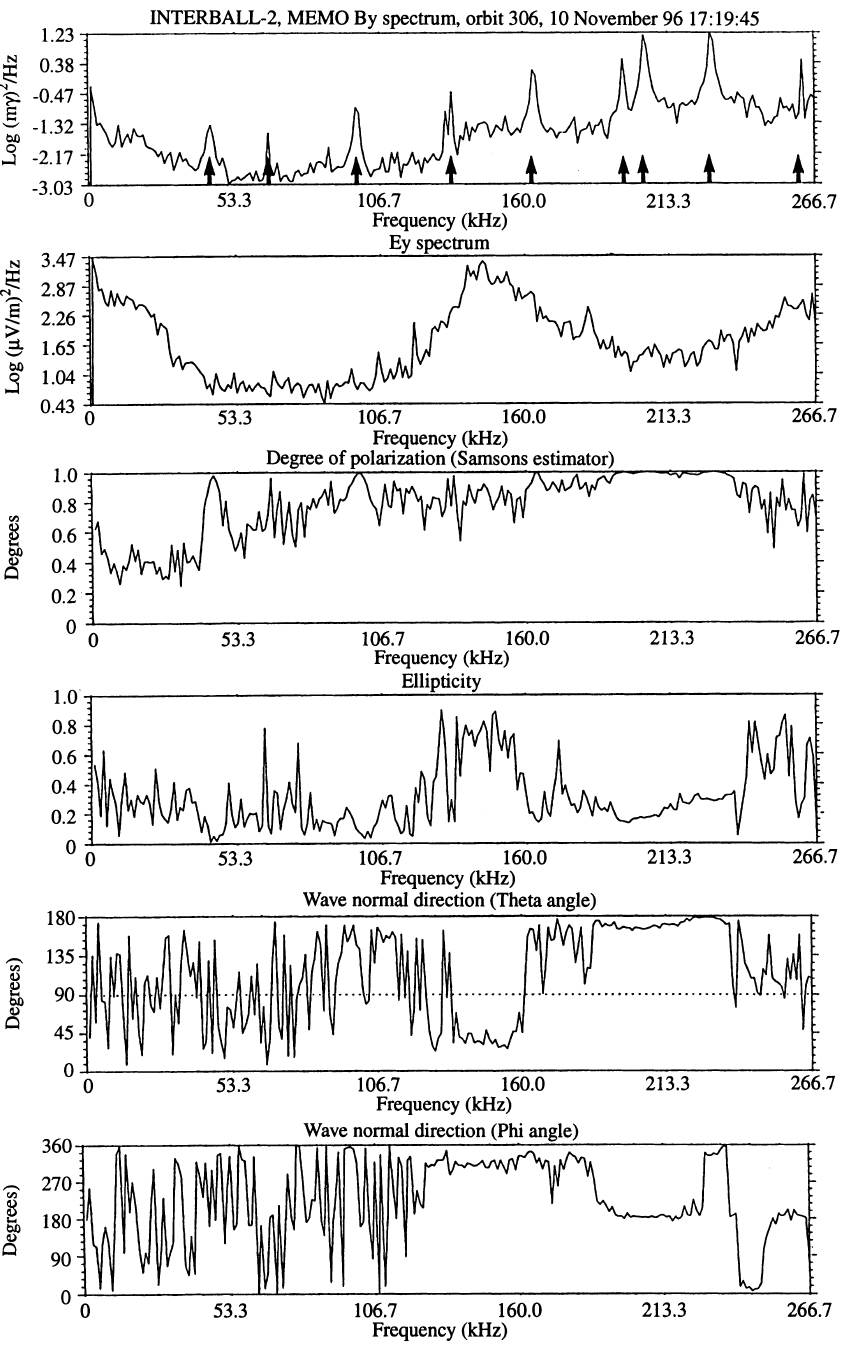
Fig. 8. Examples of fine structures